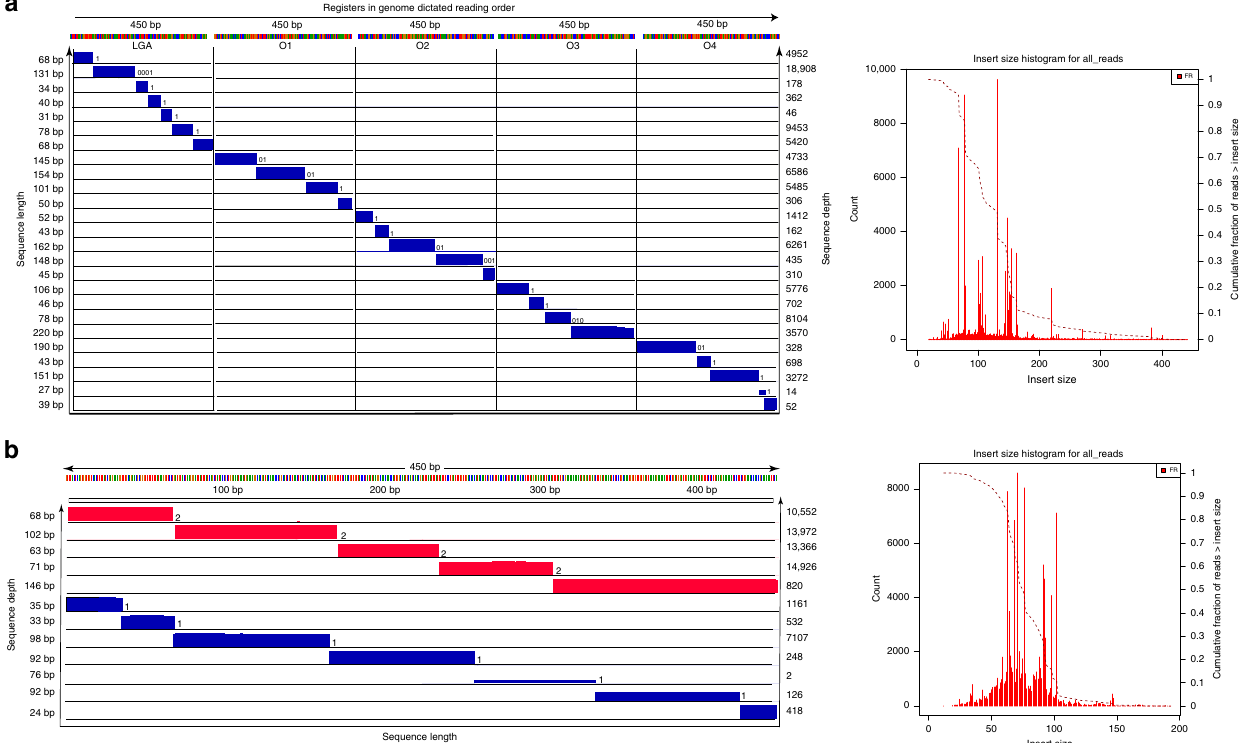
Fig. 3 Multi-register and sense-antisense recording. a Five orthogonal registers used instead of one single register. Each vertical section represents one register in genome dictated reading order, and each row shows the read lengths retrieved after sequencing analysis. Read lengths are recorded on the left and sequencing depths on the right axis. b Nicking both the sense and antisense strands. Here, the binary format is switched to ternary format, i.e., for each nicking site, a nick on the sense strand denotes 1, a nick on the antisense denotes 2, and no nick denotes 0. The coverage (left) and size distribution (right) plots verify that the register can be nicked on ten prescribed sites on both strands, six of which are located on the sense strand and four on the antisense strands, corresponding to the 10-bit string of data: 1212121211. The sense-antisense nicking approach may also be used for parallel recording on multiple registers. Source data are available in the Source Data fi